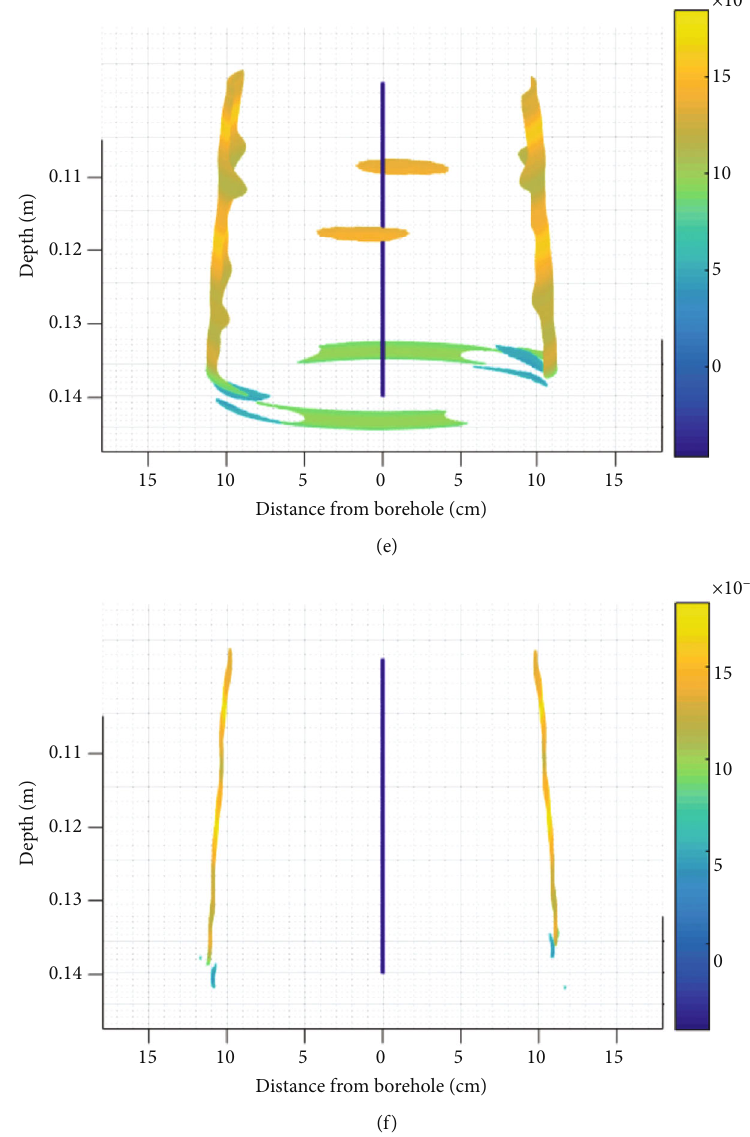
Figure 5: Three-dimensional display of model well experiment. (a) The section at a depth point of 13cm. (b) The section at a depth point of 13cm after the process. (c) Front view of the north. (d) Front north view of the north after the process. (e) The vertical view of 30 ° in the east. (f) The vertical view of 30 ° in the east after the process.